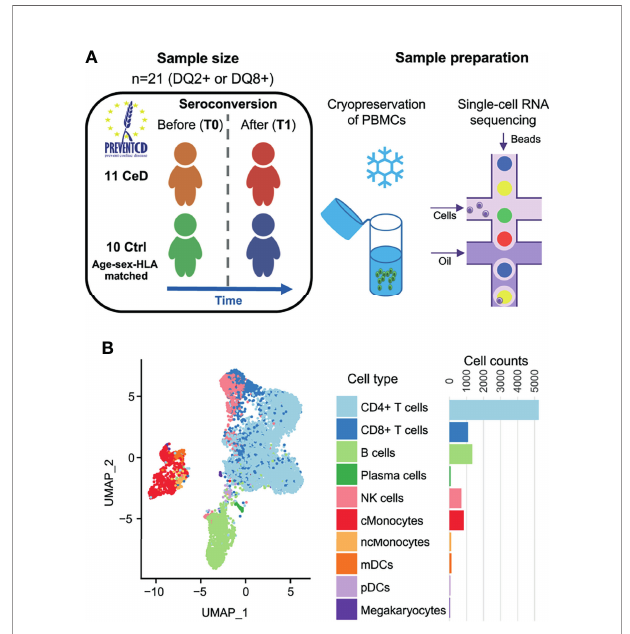
FIGURE 1 | Single-cell survey of PBMCs in CeD context. (A) Study overview. The PreventCD participants used for this study were randomly selected based on disease status, sex, age and sample availability. We processed frozen PBMC samples from 11 different children before and after they were diagnosed with CeD and from 10 genotype-, age- and sex-matched controls who had not developed CeD. Single-cell RNA-seq analyses of these samples were measured using the 10X Genomics Chromium system. (B) UMAP plot of PBMCs. After QC, the transcriptomes of 9,559 PBMCs were obtained and classi fi ed into 10 cell types using a reference dataset (22). Each dot represents a single cell. Colors correspond to different cell-types. Cell counts per cell type are displayed on the